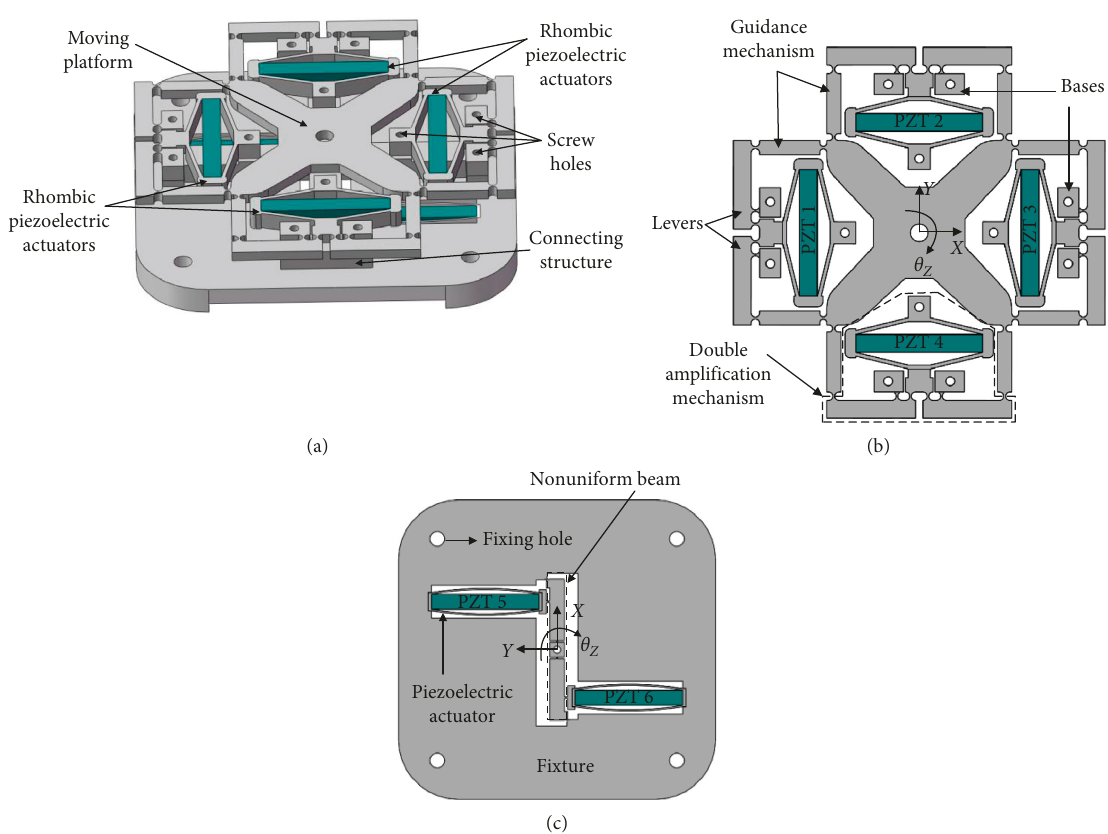
Figure 1: Model of the proposed XYθ z micropositioning mechanism: (a) 3D model; (b) translational part; and (c) rotational part.